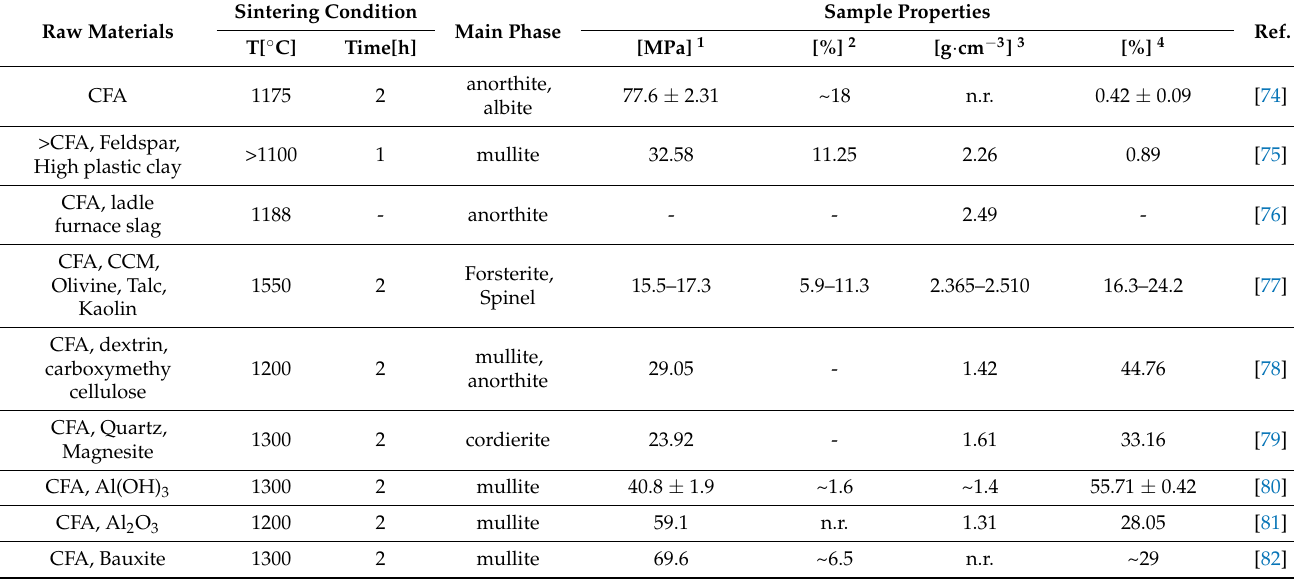
Table 4. CFA-based ceramics studies reported in the literature: raw materials, sintering condition and sample